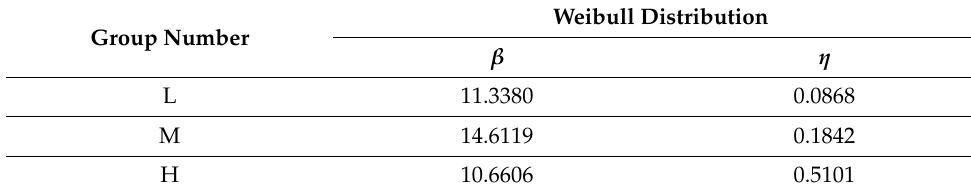
Figure 8. The Weibull distribution for the battery capacity degradation rate data. Table 3. The parameters of the Weibull